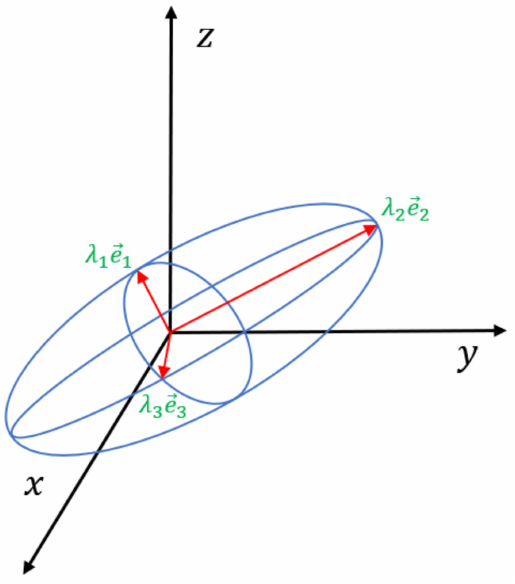
Figure 3. Definition of fiber orientation in three-dimensional